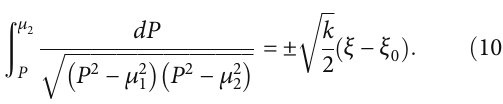
ð t , x , y Þ with a 2